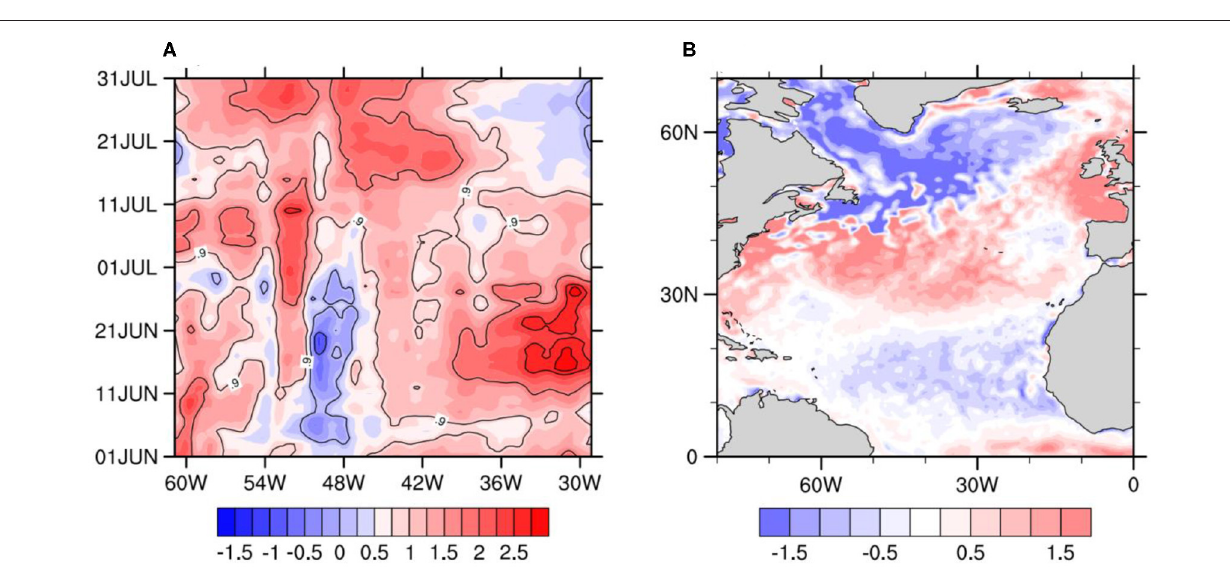
2018. These factors indicated that the midlatitude